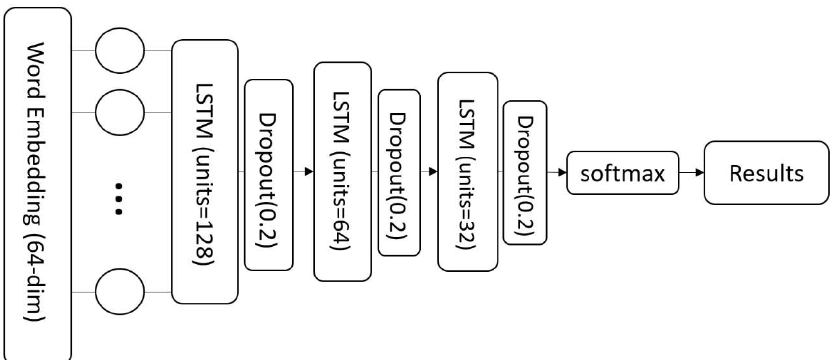
Figure 4. The illustration of the full network model.